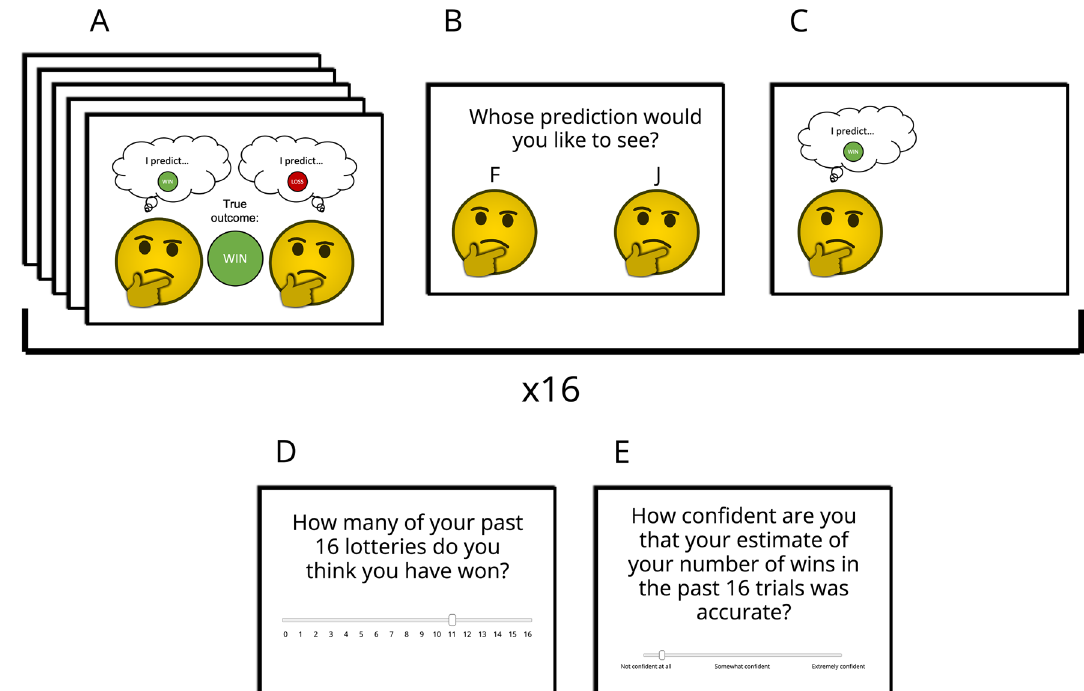
Figure 1. Experiment 1 paradigm. ( A ) Participants were first shown a series of five example predictions made by both psychics, with the true outcome of each example lottery shown. ( B ) They then selected which psychic’s prediction they would like to see for their own lottery. ( C ) Their chosen psychic then made a prediction for their lottery. The true outcome was not revealed. In each block, participants completed 16 trials. ( D ) After each block of trials, participants were asked to estimate the number of lotteries they had won within that block. ( E ) They also provided a confidence rating for their estimate on a continuous scale.